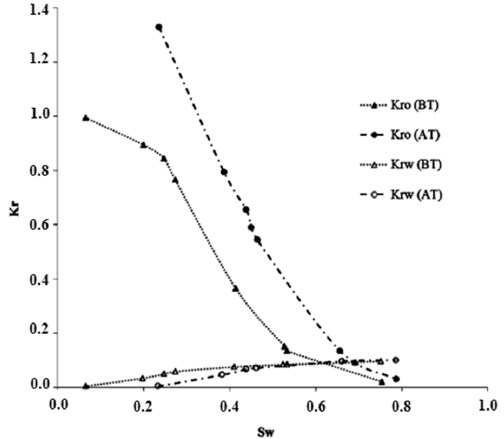
Figure 9. Relative permeability curves. The symbols are experimental data. The notation AT and BT indicates that measurements were carried out after or before nanofluid treatment [37].